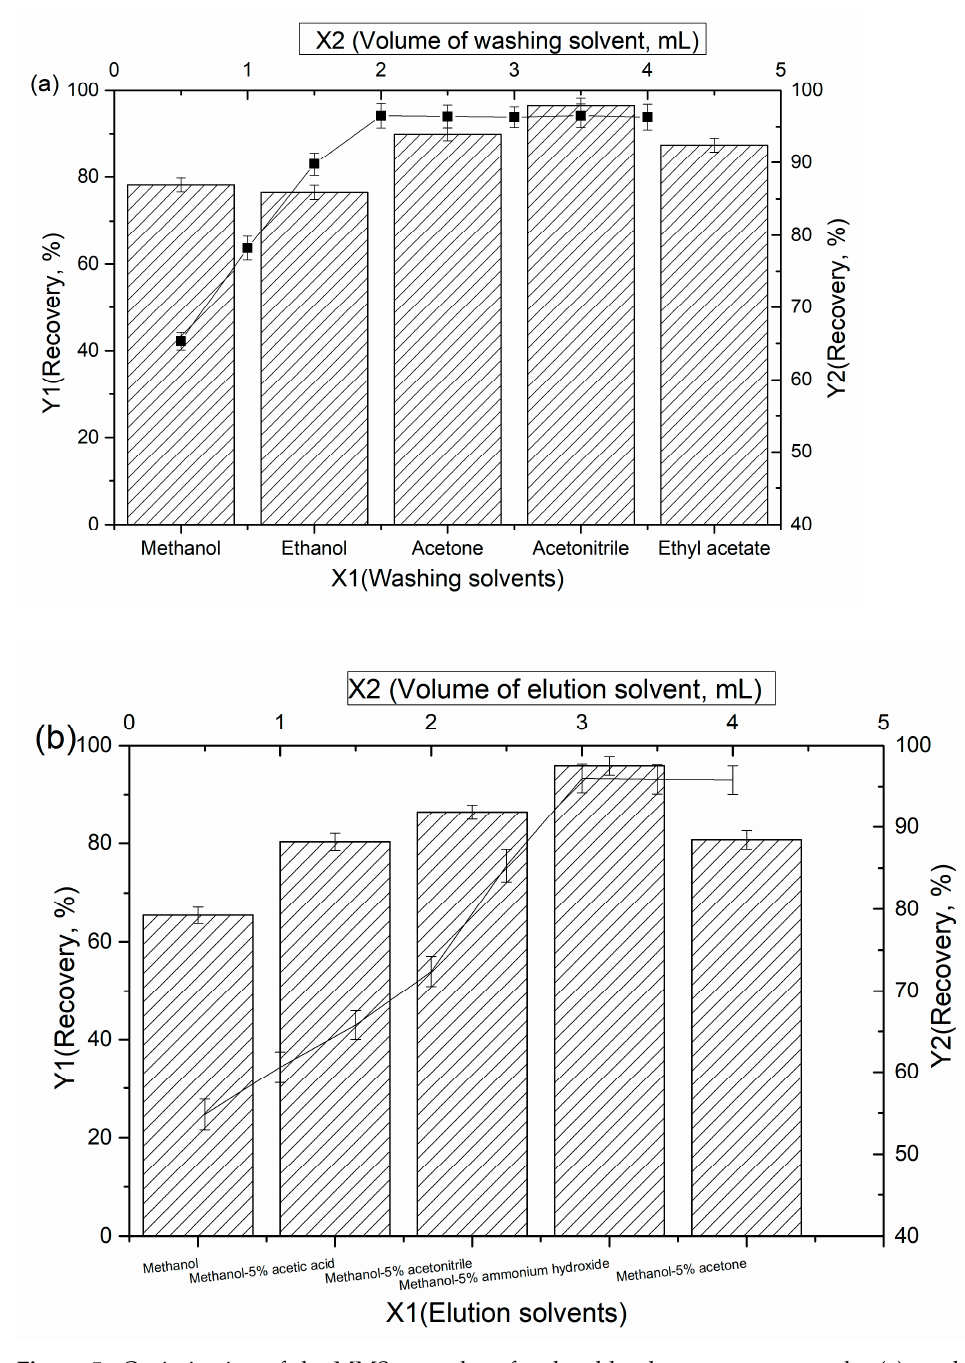
Figure 5. Optimization of the MMS procedure for the chlorobenzene compounds: ( a ) washing solvents, ( b ) elution solvents.